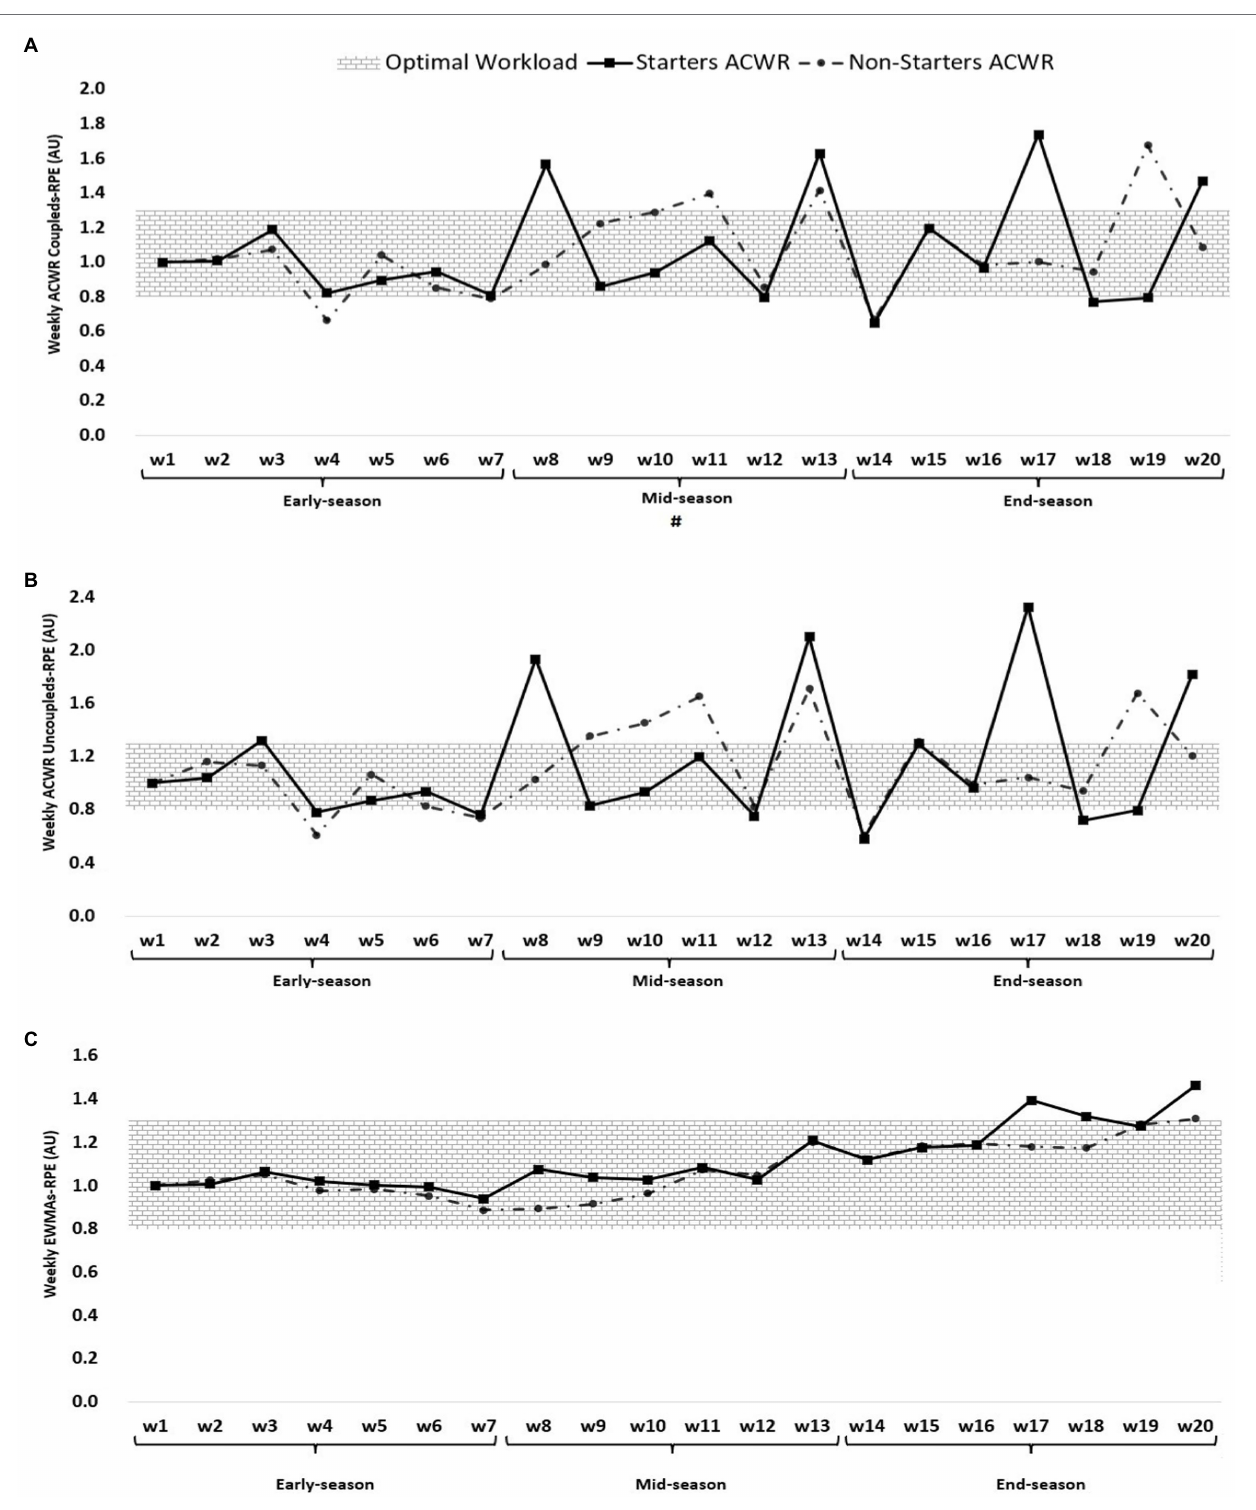
FIGURE 1 | ACWR coupled (A) and uncoupled (B) , and EWMA (C) variations calculated through the s-RPE across 20-week starters and non-starters. # Denotes significant difference between starters and